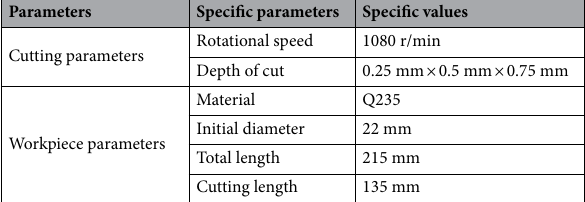
Table 5. Main parameters of the experiments.